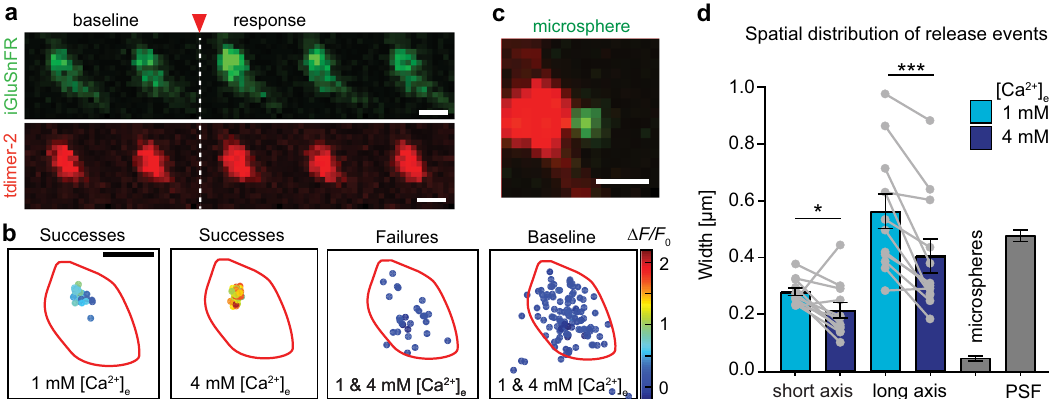
Fig. 2 | Localizing release events at Schaffer collateral boutons. a Rapid frame scans (62.5Hz) show increase in iGluSnFR fl uorescence (green) after stimulation (single trial, single AP triggered between frame #2 and #3). Scale bar: 1 µ m. b The center position and amplitude (color scale) of Gaussian fi ts to the change in green fl uorescenceare plottedwithrespecttothe bouton outline (red line).Failuretrials and random changes in baseline fl uorescence show no local clustering. c For cali- bration purposes, green fl uorescent microspheres (0.17 µ m) were imaged next to boutons. d Toquantifythe spatialdistributionof release eventsateachbouton,an